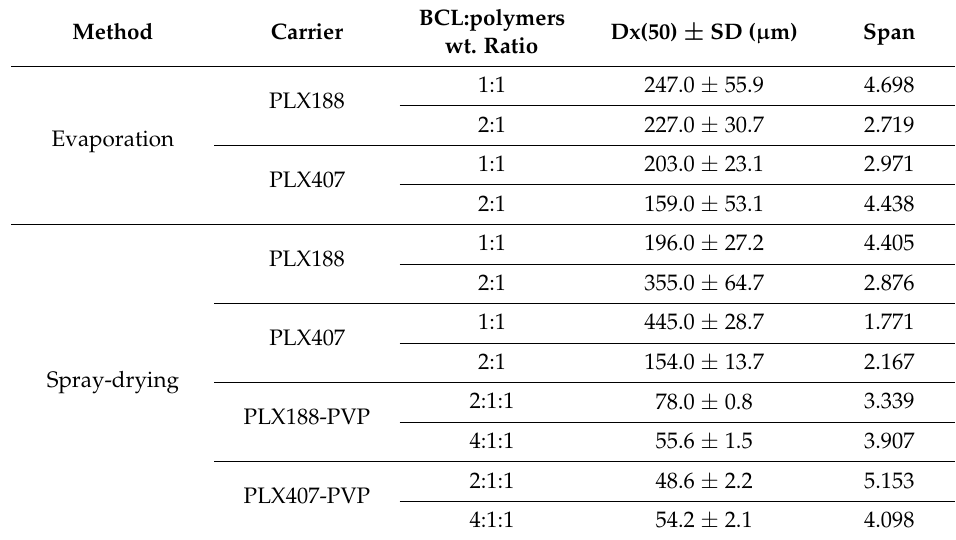
Table 1. Particle size of solid dispersions obtained using the laser diffraction method. PLX188: Poloxamer ® 188, PLX407: Poloxamer ®